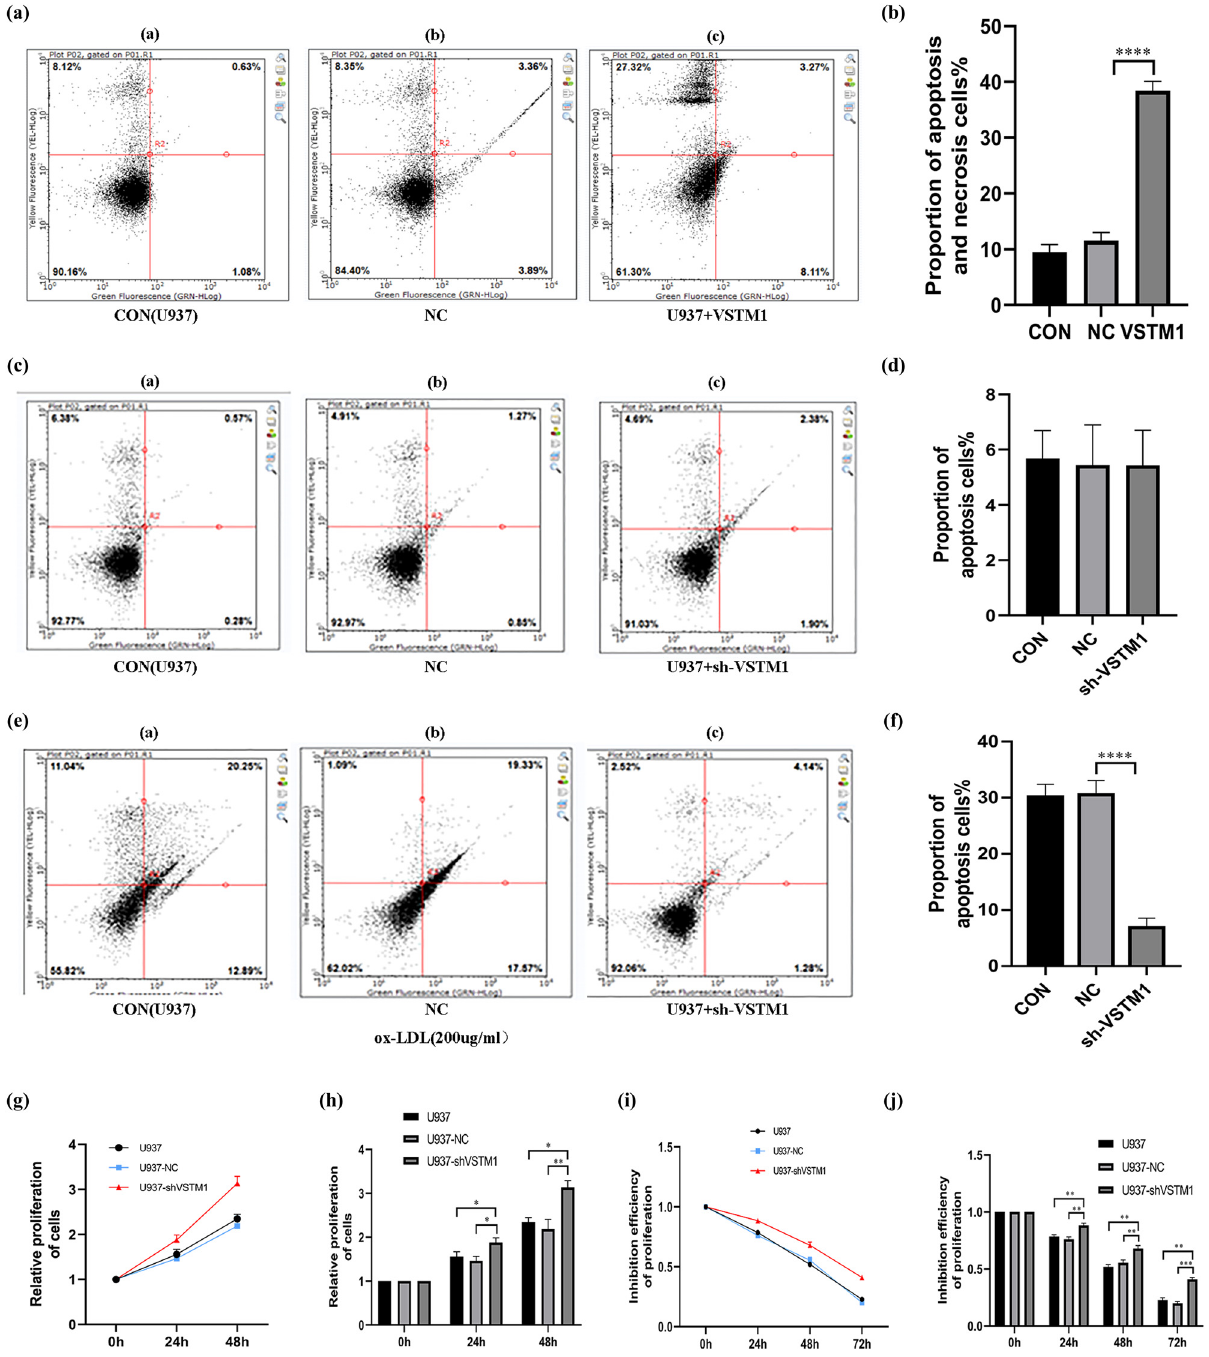
Figure 4: E ff ects of VSTM1 on apoptosis and proliferation of monocytes/macrophages stimulated by ox - LDL. ( a and b ) Detection of apoptosis after VSTM1 was overexpressed in U937 cells ( compared with the NC group, * p < 0.05, ** p < 0.01, *** p < 0.001, **** p < 0.0001, n = 3 ) . ( c and d ) Apoptosis of U937, U937 NC, and sh - VSTM1 U937 cells without exposure to ox - LDL ( compared with the control group, * p < 0.05, ** p < 0.01, *** p < 0.001, **** p < 0.0001, n = 3 ) . ( e and f ) Apoptosis of U937, U937 NC, and sh - VSTM1 U937 cells exposed to ox - LDL ( compared with the NC group, * p < 0.05, ** p < 0.01, *** p < 0.001, **** p < 0.0001, n = 5 ) . ( g ) and ( h ) Proliferation of U937, U937 NC, and sh - VSTM1 U937 cells without exposure to ox - LDL ( compared with the control group, * p < 0.05, ** p < 0.01, *** p < 0.001, **** p < 0.0001, n = 5 and the NC group, * p < 0.05, ** p < 0.01, *** p < 0.001, **** p < 0.0001, n = 5 ) . ( i ) and ( j ) Inhibitory e ff ect of ox - LDL on the growth of U937, U937 NC, and sh - VSTM1 U937 cells ( compared with the control group, * p < 0.05, ** p < 0.01, *** p < 0.001, **** p < 0.0001, n = 5 and compared with the NC group, * p < 0.05, ** p < 0.01, *** p < 0.001, **** p < 0.0001, n = 5 ) . Statistical analysis was performed using Pearson ’ s chi - square test ( n ≥ 5 ) or Fisher ’ s exact test ( n < 5 ) with subsequent multiple comparisons using chi - square with the Bonferroni correction for categorical variables. One - way ANOVA with subsequent post hoc multiple comparisons was used for continuous variables with the Student – Newman – Keuls